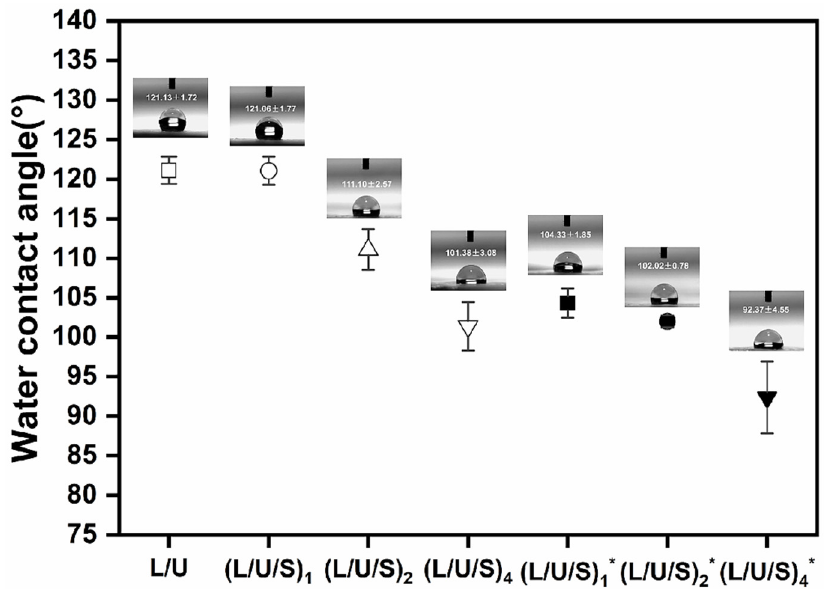
Figure 5. Water contact angle of PU/PLCL/CMCS fibers. (L/U/S) 1* , (L/U/S) 2* , (L/U/S) 4* referred to the sample after (L/U/S) 1 , (L/U/S) 2 , (L/U/S) 4 were cross-linked, respectively.